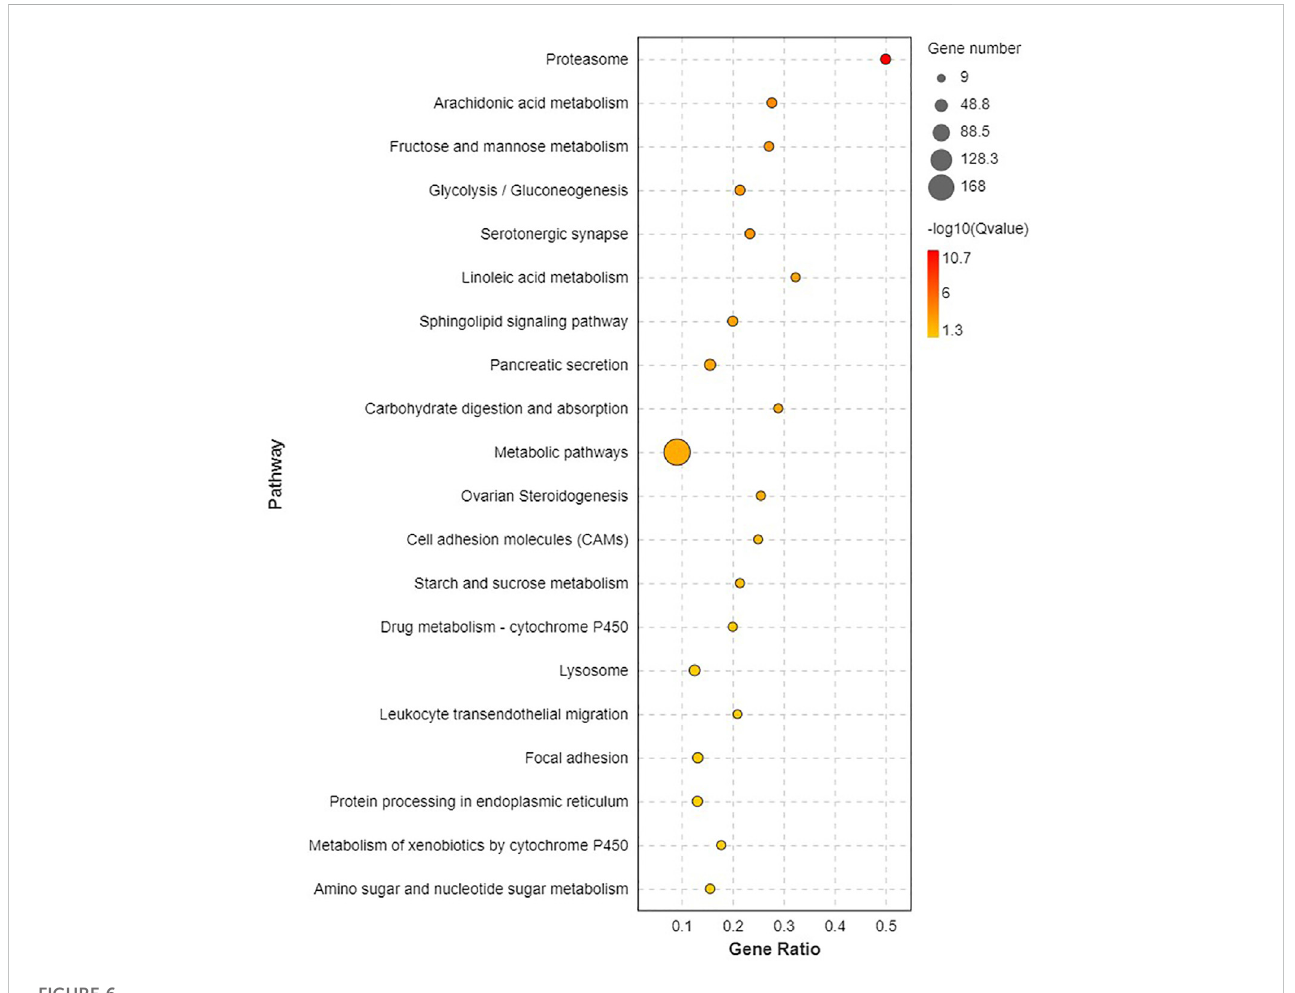
The fi rst 20 KEGG pathway signi fi cantly